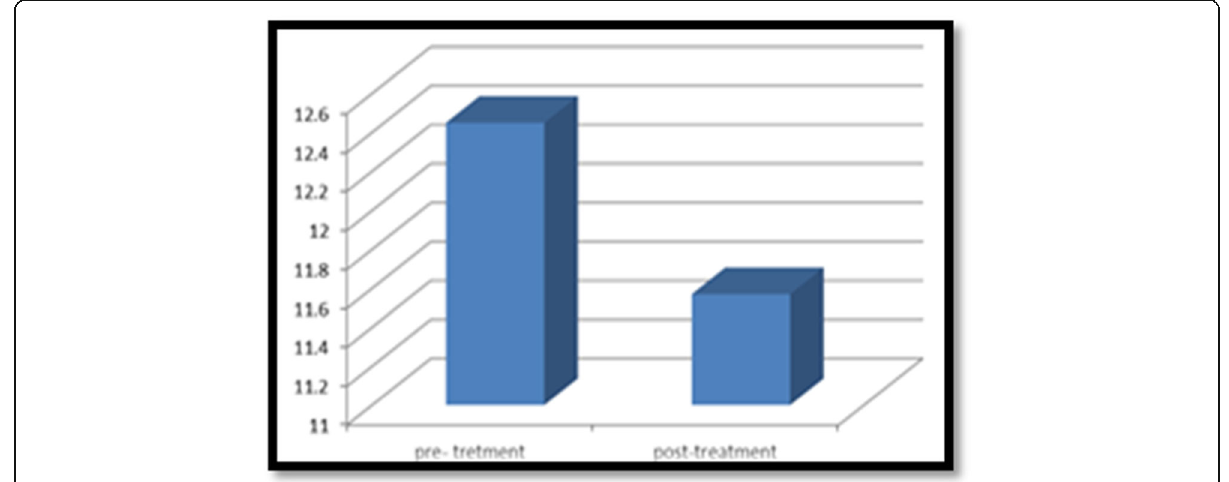
Fig. 3 Mean values of FCR H-reflex pre- and